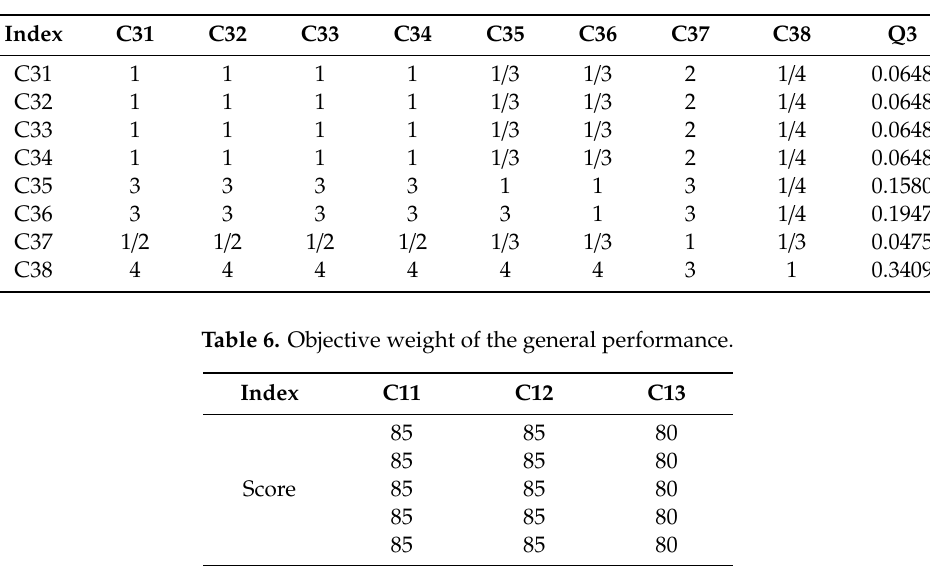
Table 5. Subjective weight of the safety performance.